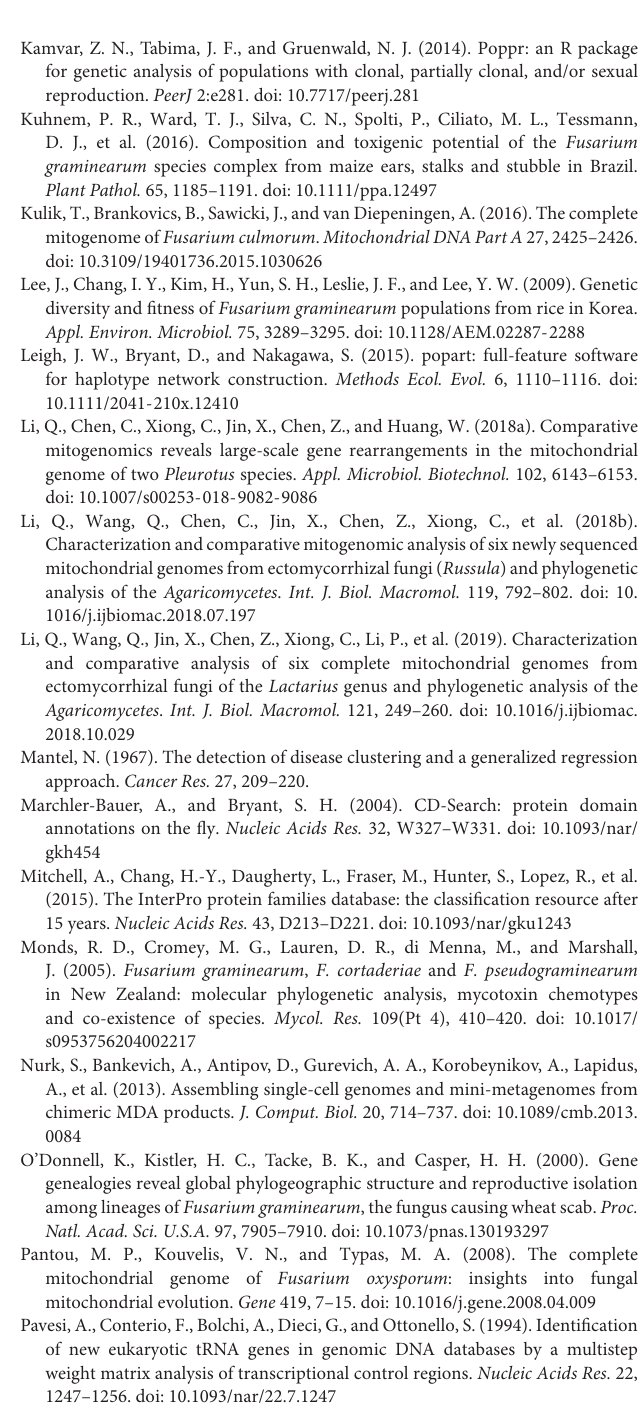
FIGURE S1 | Minimum spanning network inferred from non-intronic regions from 210 F. asiaticum isolates. Each black line on lineage indicates one SNP. The number of each haplotype is reflected by area of each circle. FIGURE S2 | A maximum likelihood phylogenetic tree constructed based on the non-intronic (exonic and intergenic regions) alignment of 210 F. asiaticum , 24 F. graminearum, and one F. culmorum .